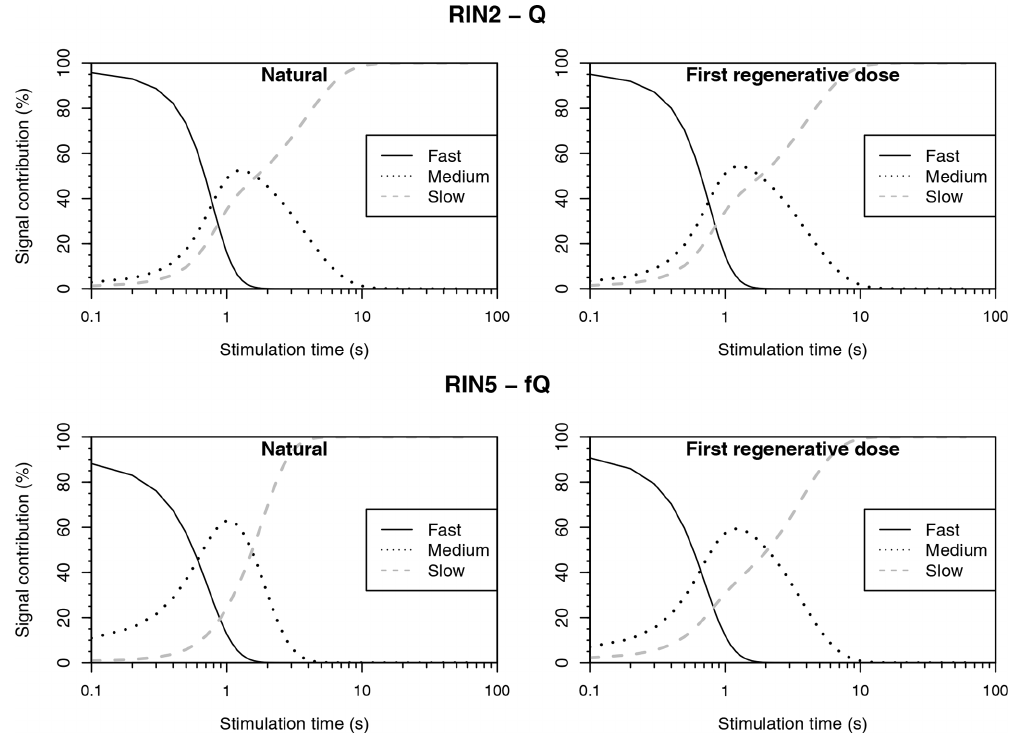
Figure 8. Component deconvolution of the natural and regenerative OSL response of RIN2 Q and RIN5 f